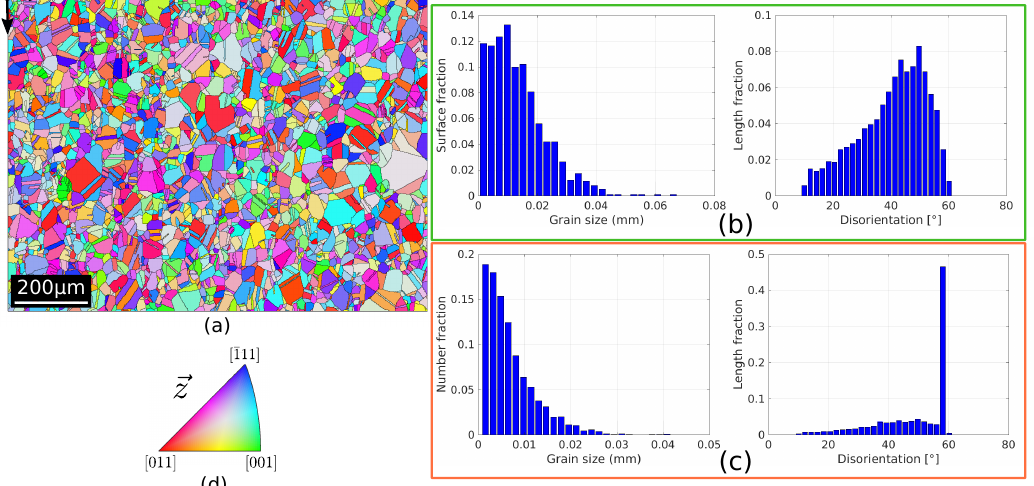
Figure 2. Initial microstructure properties determined by EBSD measurements. ( a ) IPF-z map. ( b ) Grain size distribution and DDF of grain boundaries excluding Σ 3 TBs. ( c ) Grain size distribution as measured in 2D sections and DDF of grain boundaries including Σ 3 TBs; the sharp peak on the DDF at 60 ◦ corresponds to Σ 3 TBs. ( d ) Standard triangle used to color the orientation maps IPF-Z (indicating which crystallographic direction is lying parallel to the direction perpendicular to the scanned section).